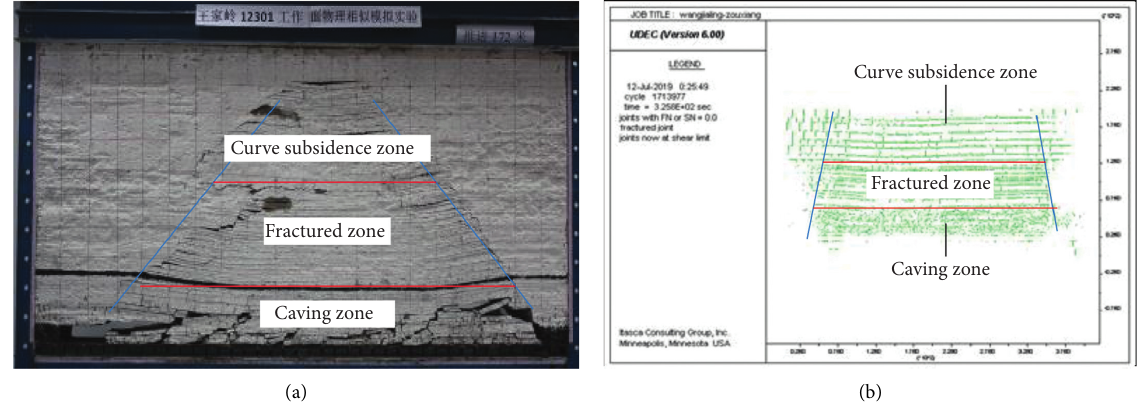
Figure 4: Distribution characteristics of overlying fracture field in stable mining period. (a) Physical simulation. (b) Numerical